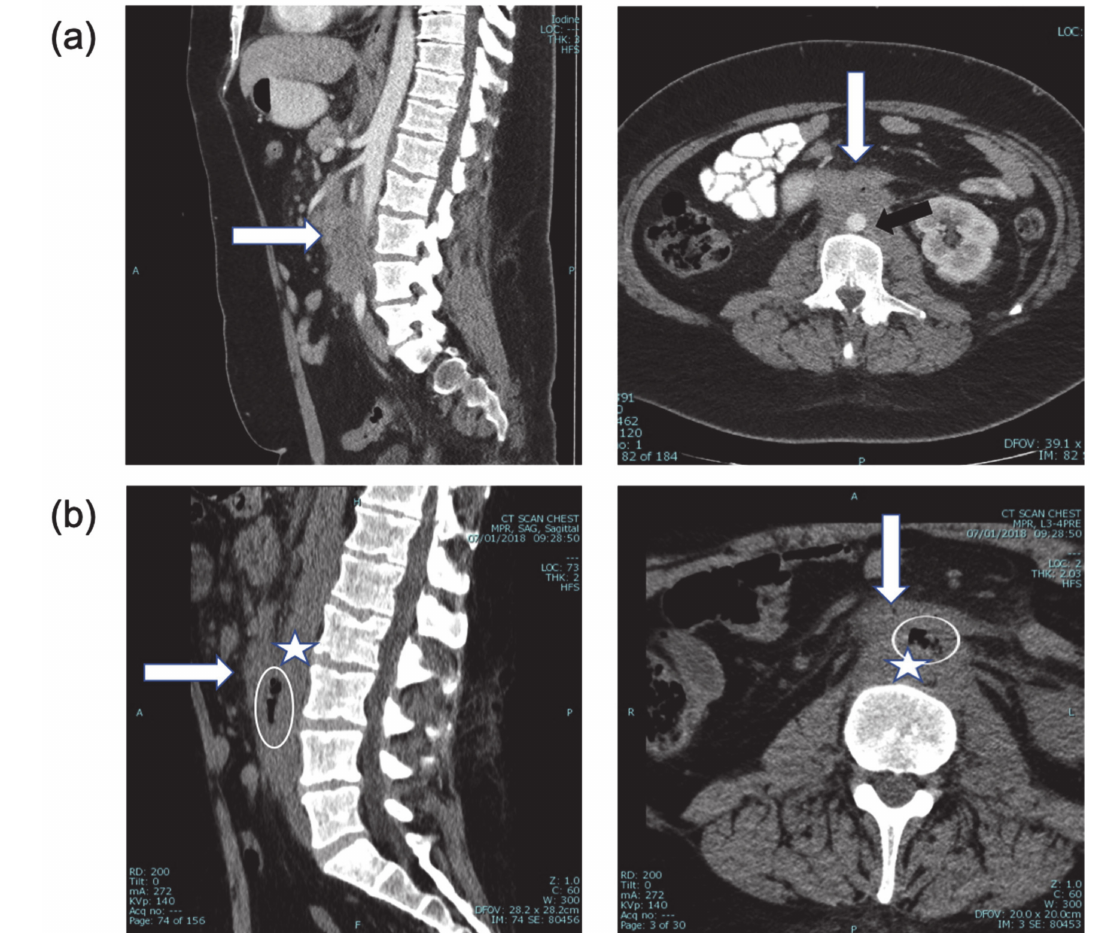
Figure 1. ( a ) CT + intravenous contrast, three months prior to bleeding event, showing the extent of disease (white arrow) around the abdominal aorta (black arrow) and relationship to duodenum (sagittal and axial views). ( b ) CT of the spine one month prior to bleeding. Sagittal and axial views. With retrospect, air (encircled) was identified between the aorta (star) and duodenum (arrow), highly suspicious for aorto-duodenal